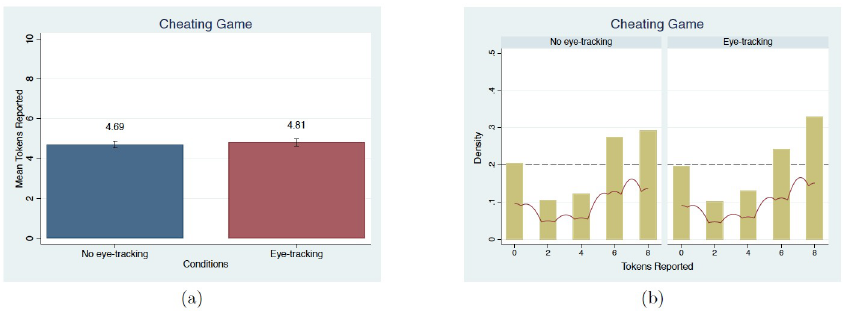
Fig 9. Mean in the average number of tokens reported in 10 periods and distribution comparisons in the number of tokens reported in 10 periods. Note. Dashed line indicates the expected density of each token occurring, in which a truthful distribution (0.2) [92, 94]. Red lines in (b) present the univariate kernel density